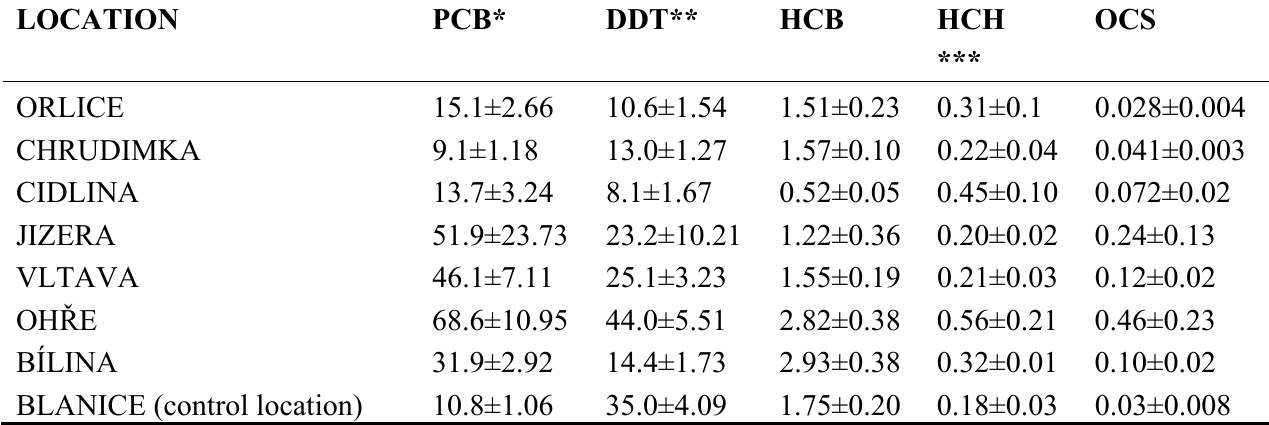
Table 2. Content of persistent organic pollutants in